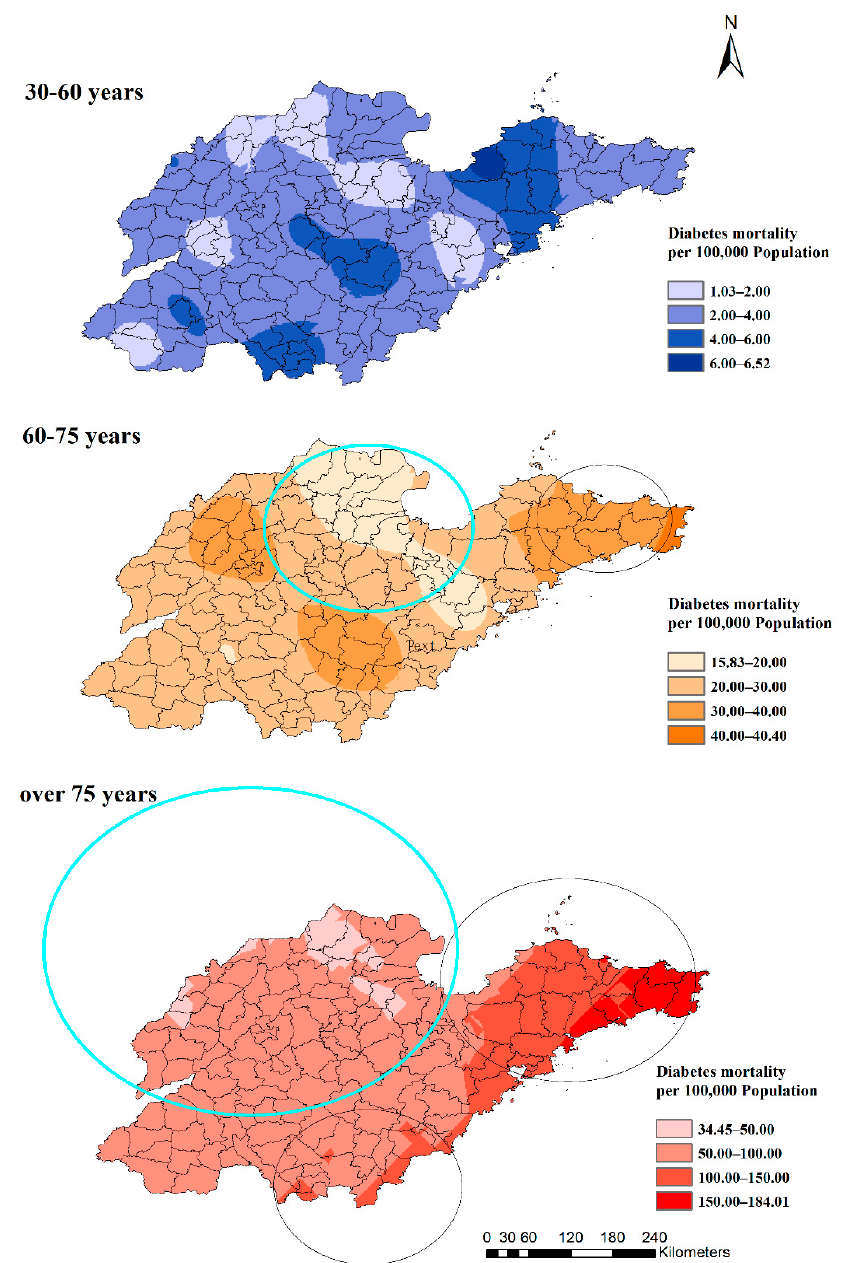
Figure 6. Estimated diabetes mortality by age groups with clusters in Shandong Province, China,